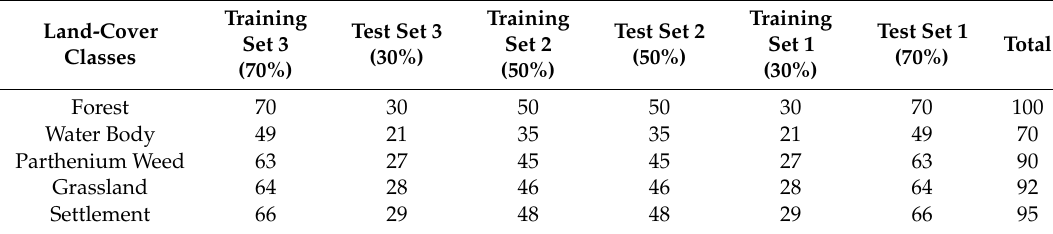
Table 1. Training and test dataset combinations for land cover